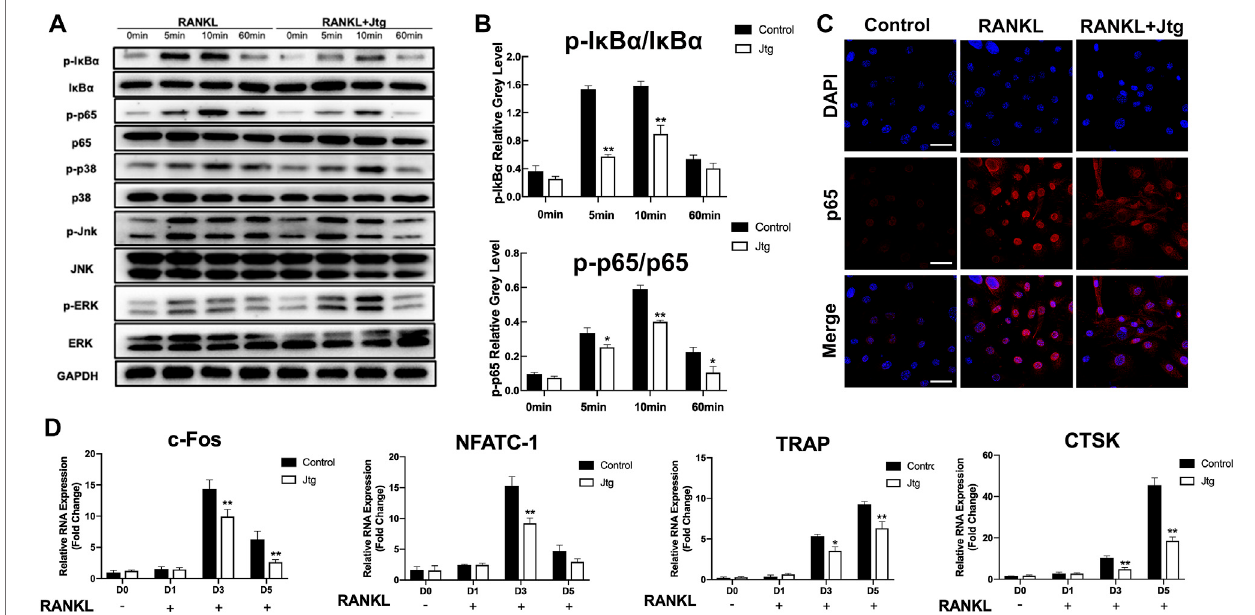
FIGURE 2 | Jtg inhibits RANKL-induced osteoclast-speci fi c gene expression and NF- κ B signaling pathway without affecting MAPK pathway. (A) Western blot assaywasperformedtoanalyzetheexpressionofosteoclastogenesis-relatedtranscriptionfactorsintheNF- κ BandMAPKsignalingpathwaysincludingI κ B α ,p65,p38, ERK, and JNK. (B) The band intensities corresponding to p-I κ B α /I κ B α and p-p65/p65. (C) Immuno fl uorescence staining was performed to analyze the nuclear translocation of p65 upon RANKL stimulation in BMMs, scale bar, 50 μ m. (D) The expression of osteoclast-speci fi c mRNA, including c-FOS, NFATc1, TRAP, and cathepsinK(CTSK)wasanalyzedusingRT-PCR.ThemRNA-expressionlevelswerenormalizedrelativetotheexpressionofGAPDHmRNA.*Comparedwiththecontrol group (* p < 0.05; ** p <